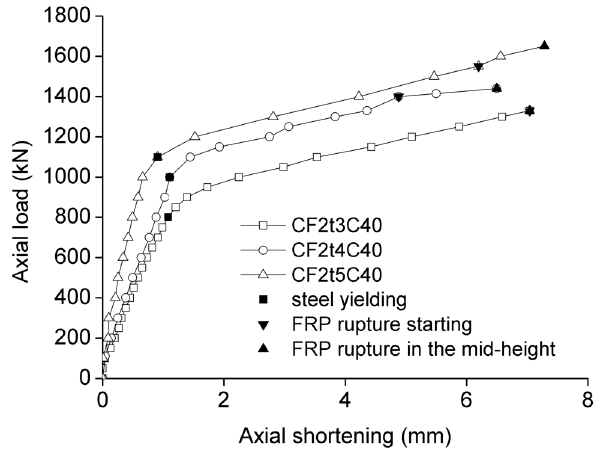
Figure 5 . Axial load vs. axial shortening curves in terms of the thickness of the steel tube.